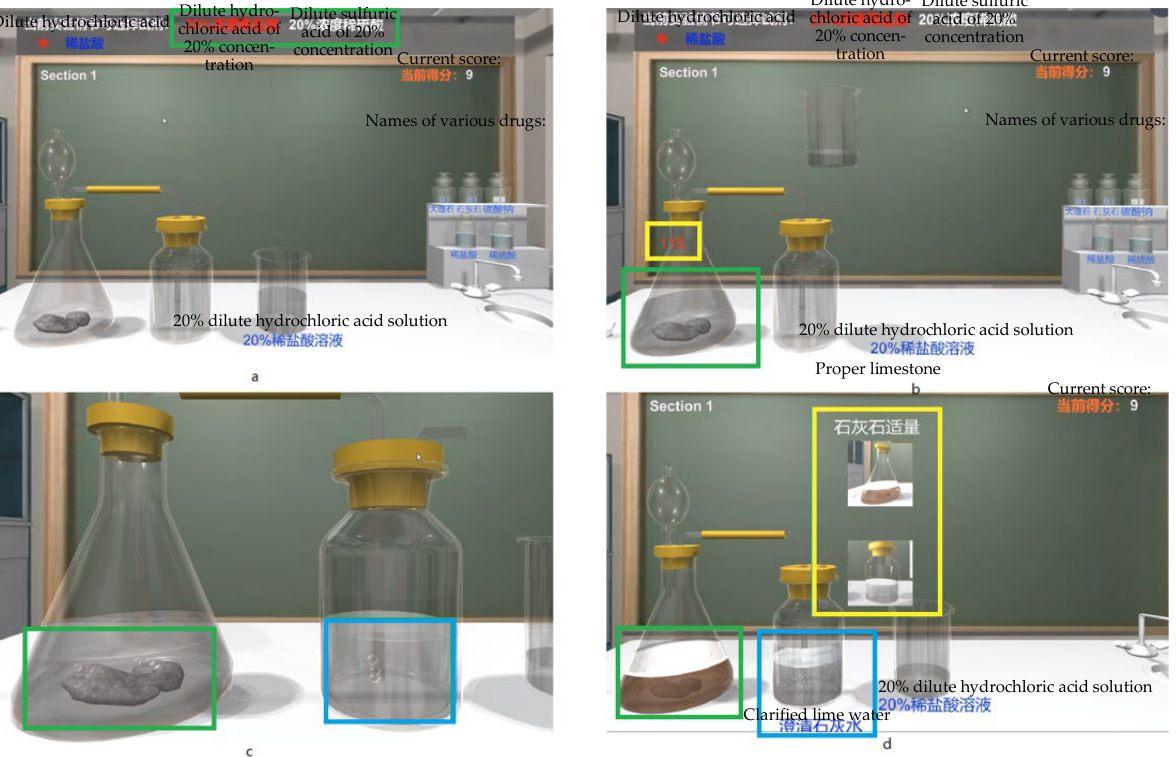
Figure 7. Limestone and dilute hydrochloric acid experiment scene 2. ( a ). Drug selection interface. ( b ). Quantitative interface of dumped drugs. ( c ). Realization of phenomenon amplification interface. ( d ). Implementation of phenomenon comparison interface.